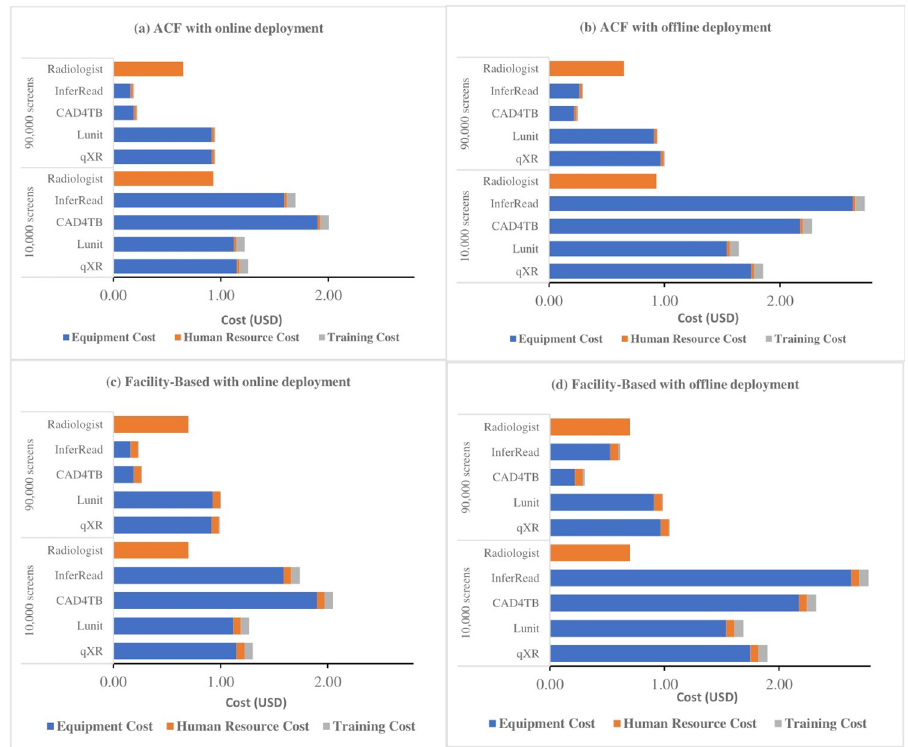
Fig 3. Disaggregated cost per screen with CAD vs. radiologist for different scenarios and throughput volumes.